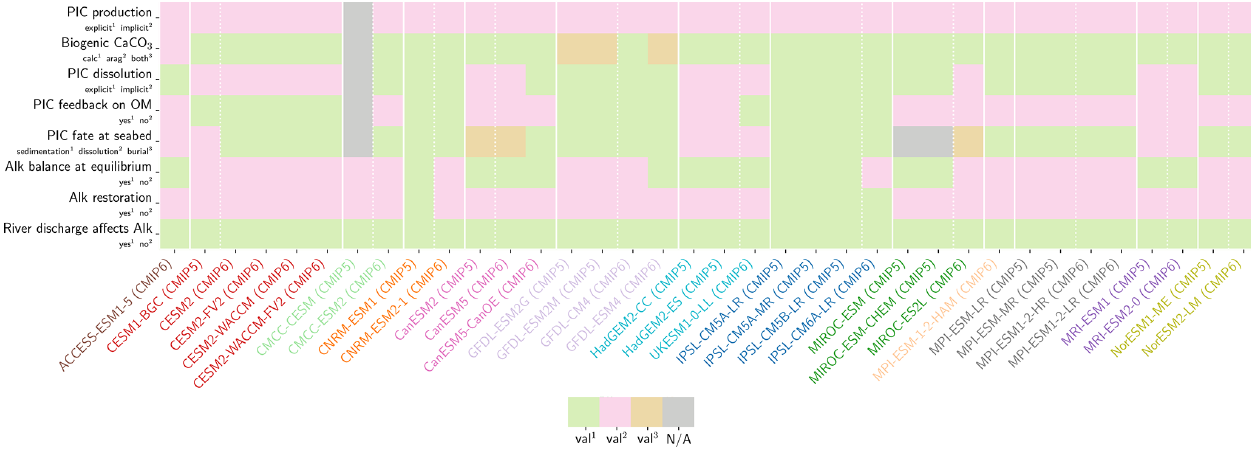
Figure 2. ESM representation of processes related to Alk and the carbonate pump. The representation and/or parameterization of each process has a subscript code associated with the potential values (1, 2, 3 or is not applicable – N/A). A more complete representation of this figure is available in Fig. C1, with further model details in Supplement Table